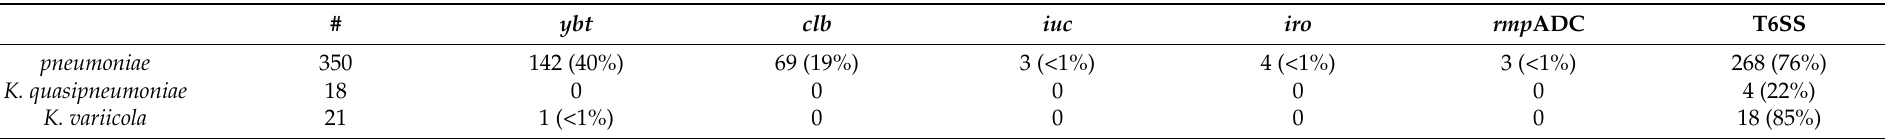
Table 3. Prevalence of virulence loci in Klebsiella species in Brazil.